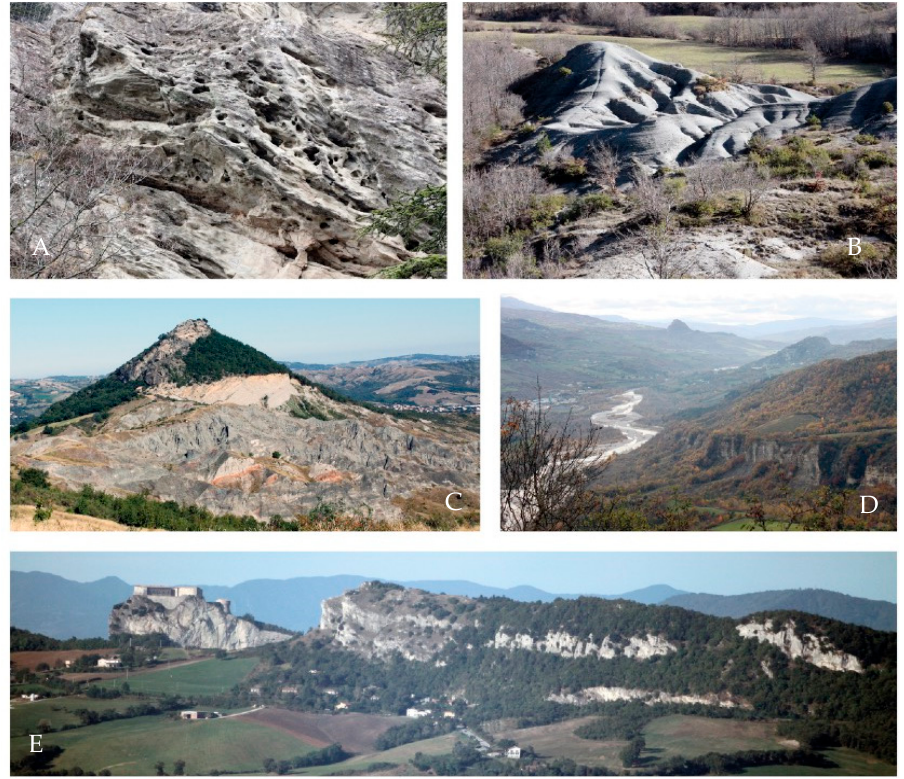
Figure 5. Cold-colored landscapes of Paesaggeo online survey: ( A ) honeycomb erosion of Mt. Perticara; ( B ) Pratieghi marls; ( C ) Maiolo cliff and badlands; ( D ) Costa dello Speco and Marecchia River; ( E ) San Leo and the Tausani cliff.